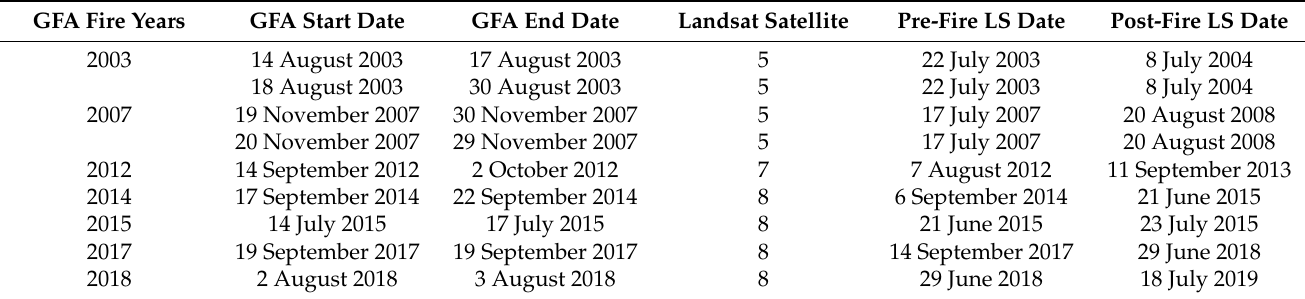
Table 1. Dates of fires detected by the Global Fire Atlas (GFA) and Landsat (LS) imagery used to assess fire